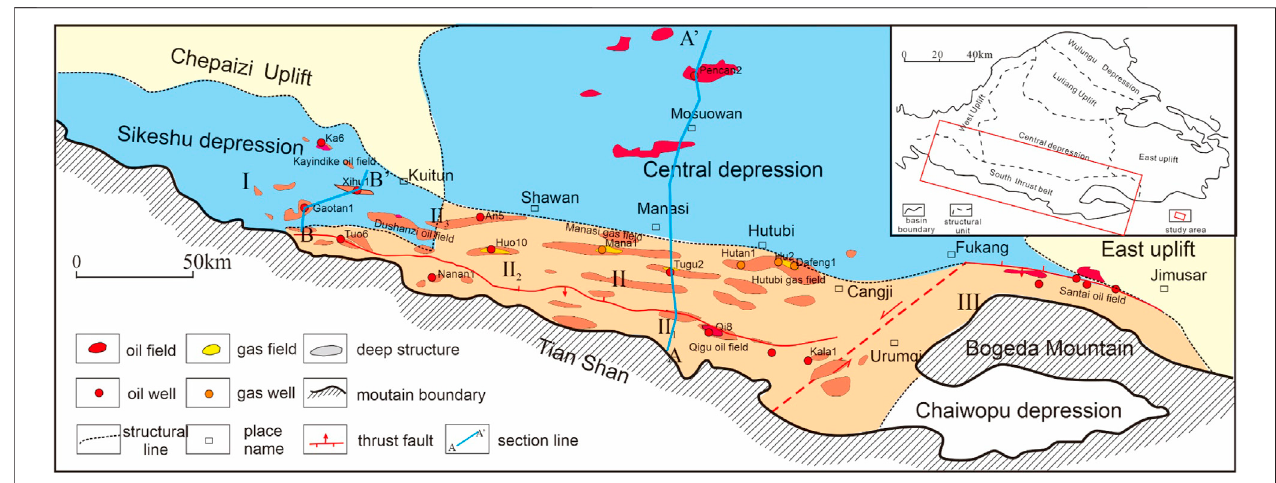
FIGURE 1 | Map showing the structural units and oil – gas fi elds in the South Junggar foreland basin. The thrust belt is divided into a western segment (I; west to Kuitun), a middle segment (II; between Kuitun and Urumqi), and an eastern segment (III; east to Urumqi). In the middle segment, three en-echelon anticlinal belts strike broadly E – W, that is, the fi rst row of anticlines (II 1 ), the middle row of anticlines (II 2 ), and the third row of anticlines (II 3 ).